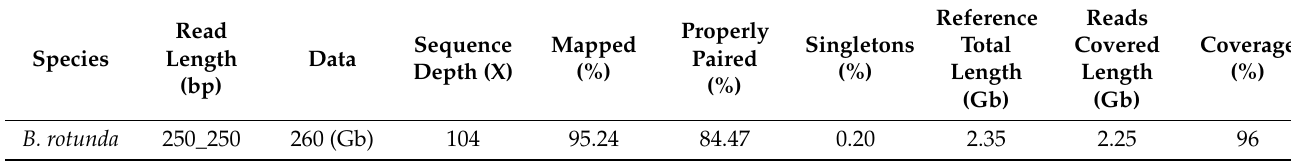
Table 2. Evaluation of completeness of the final